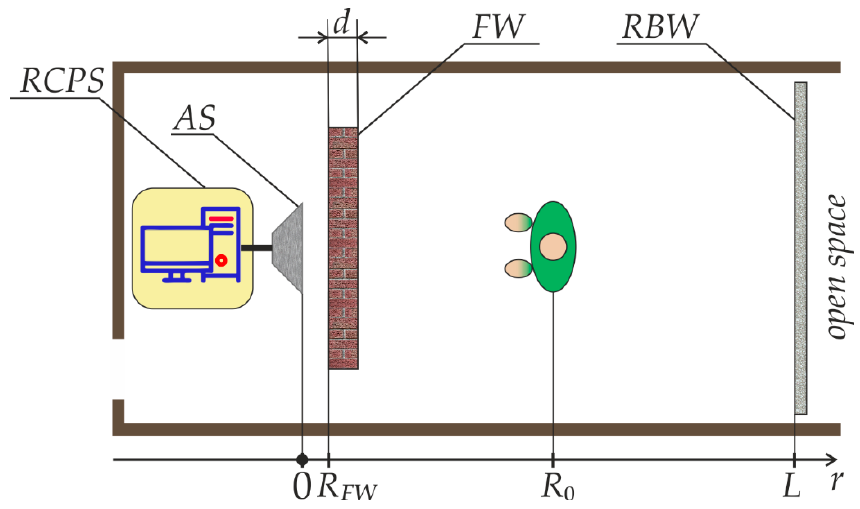
Figure 1. The radar measurement site.